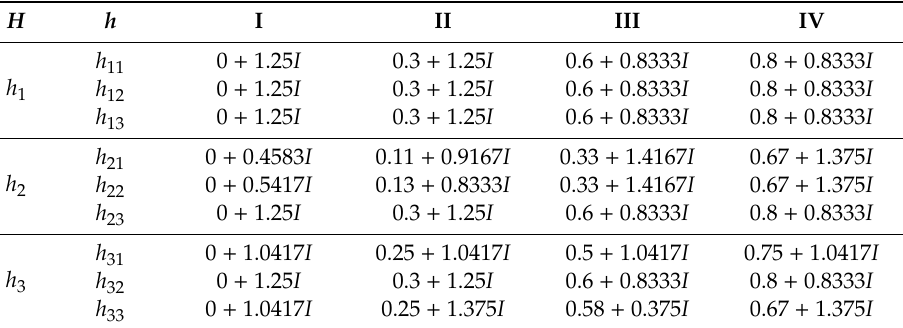
Table 3. Subattributes of slopes expressed as neutrosophic